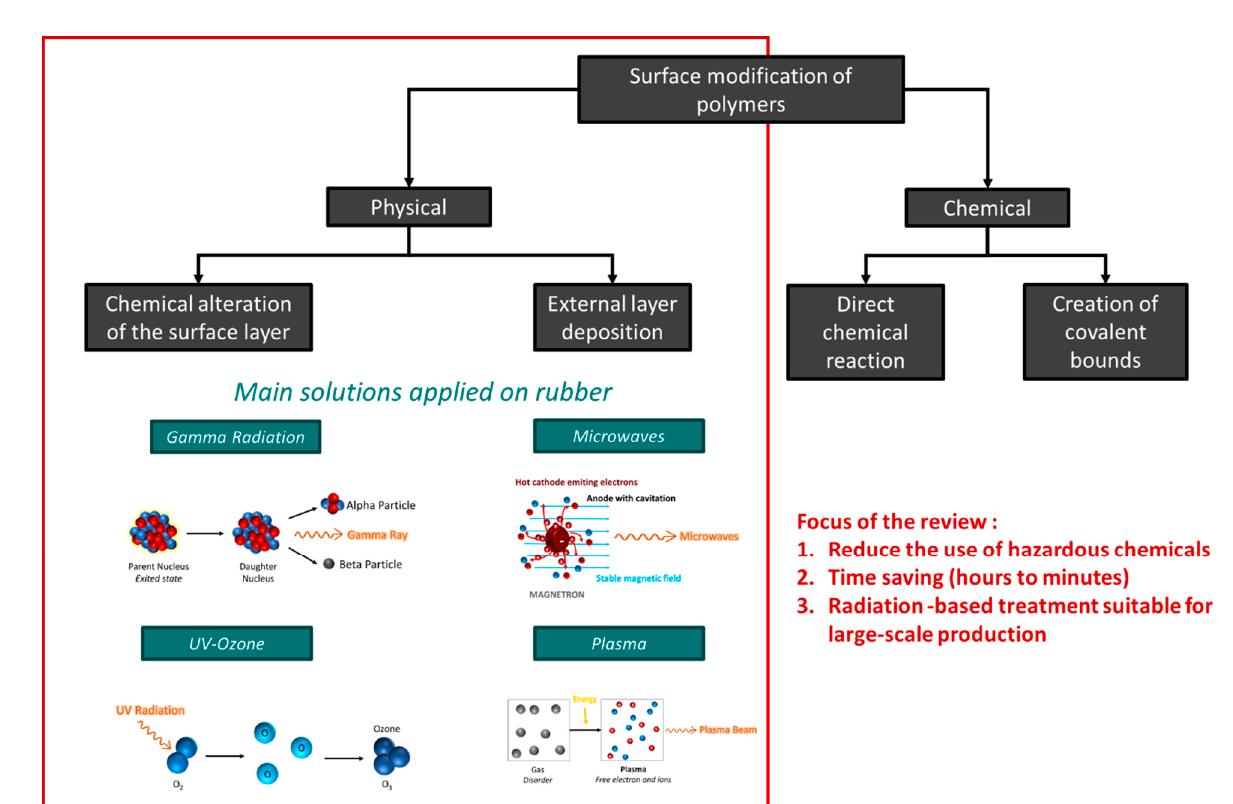
Figure 2. Scheme of the different possible treatment methods and the main solutions described in this review (adapted from [22,35–45]).